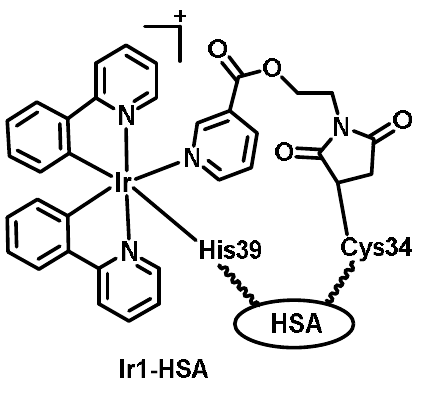
Figure 24. Structures of MeTPAE and Ir1-HSA.